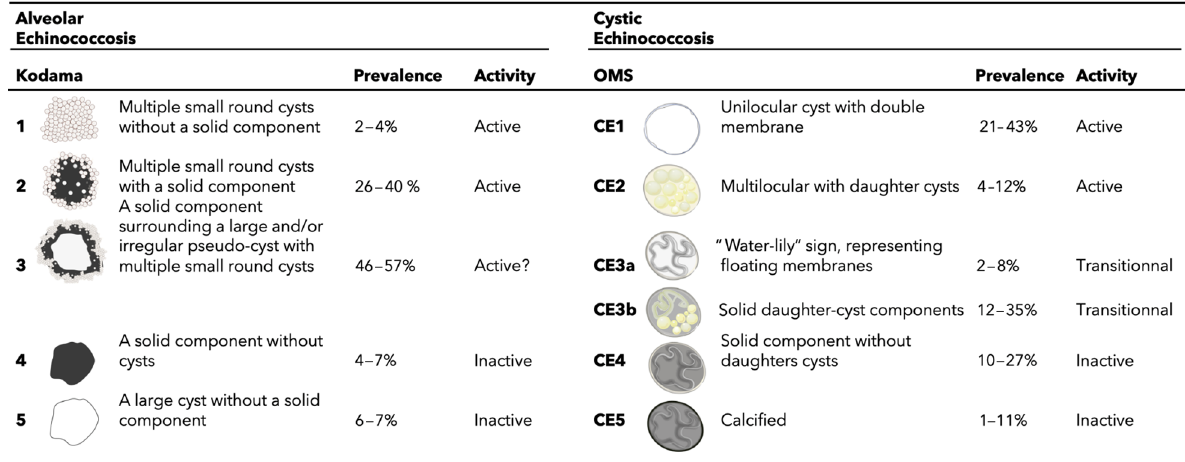
Table 3 Classifications of AE and CE, and their correlation with parasitic activity and